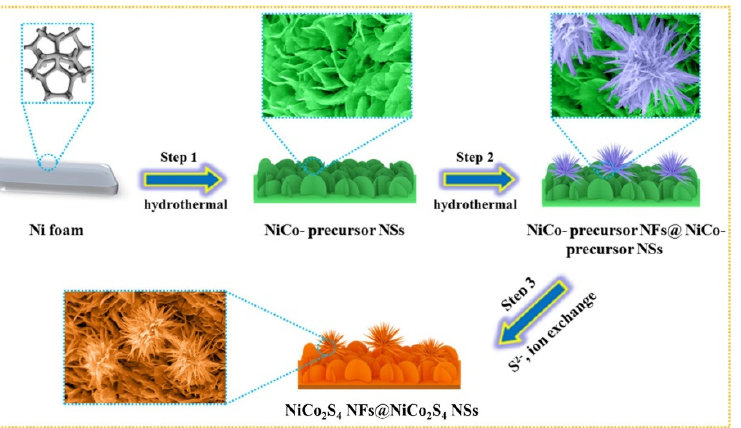
Figure 14. Schematic diagram showing the fabrication of NiCo 2 S 4 nanoflowers @NiCo 2 S 4 nanosheets. Reproduced with permission from Wenling Wu, Hierarchical structure of Self-Supported NiCo 2 S 4 Nanoflowers@NiCo 2 S 4 nanosheets as high rate-capability and cycling-stability electrodes for advanced supercapacitor; published by Elsevier, 2021 [170] .